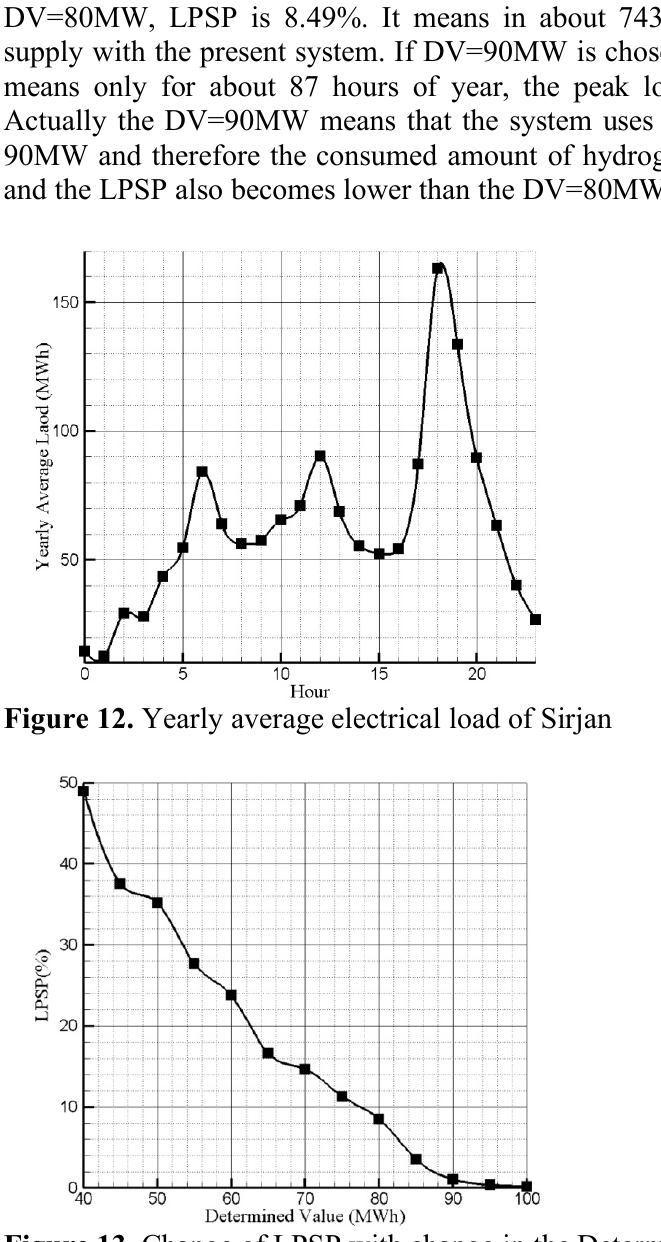
Figure 13. Change of LPSP with change in the Determined Value